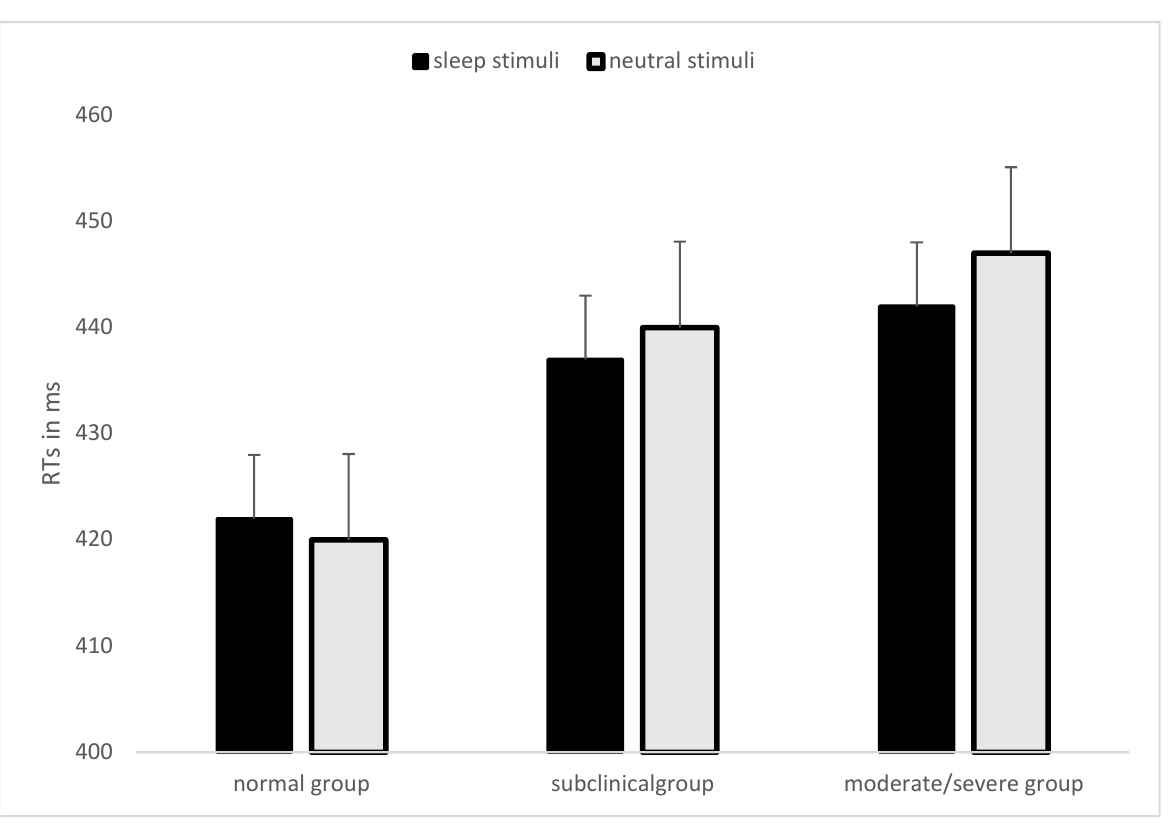
Figure 1. Mean RTs for detecting the probe appeared in the same position as the sleep-related stimuli (histogram in black) and mean RTs for detecting the probe appeared in the same position as the neutral stimuli (gray histogram), for sleep-neutral couples only, in each sleep group defined based on the ISI score. The bars indicate the mean standard error.